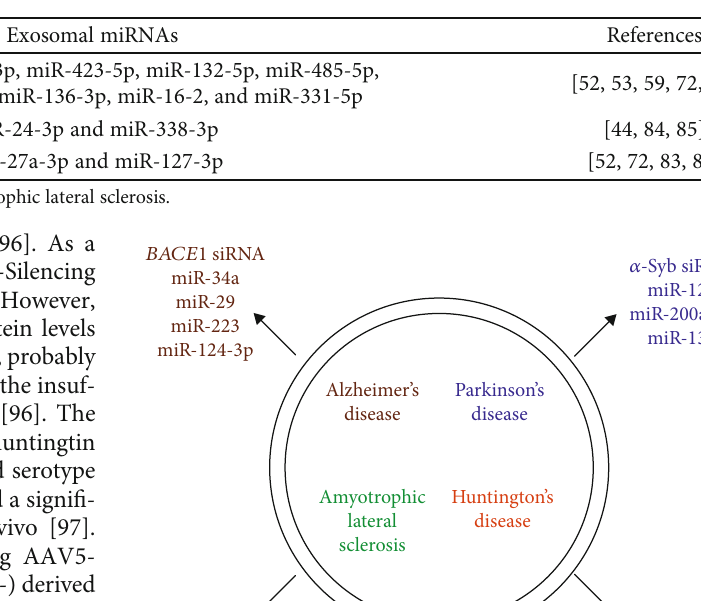
Table 2: Exosomal miRNAs dysregulated in more than one neurodegenerative disorder.